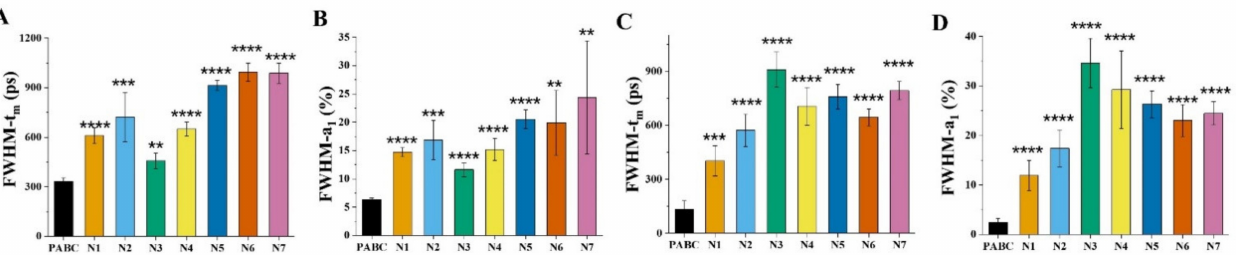
Figure 5. The FWHM of the FAD t m and a 1 distribution curves of PABC and the normal group (including seven pairs of normal maternal blood and umbilical cord blood, N1-N7). ( A ) FAD- t m of maternal blood, ( B ) FAD- a 1 of maternal blood, ( C ) FAD- t m of cord blood, ( D ) FAD- a 1 of cord blood (** p < 0.01, *** p < 0.001, **** p <